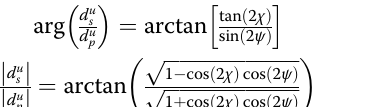
ffiffiffiffiffiffiffiffiffiffiffiffiffiffiffiffiffiffiffiffiffiffiffiffiffiffiffi p 1 (cid:1) cos 2 χ ð Þ cos 2 ψ ð Þ ffiffiffiffiffiffiffiffiffiffiffiffiffiffiffiffiffiffiffiffiffiffiffiffiffiffiffi